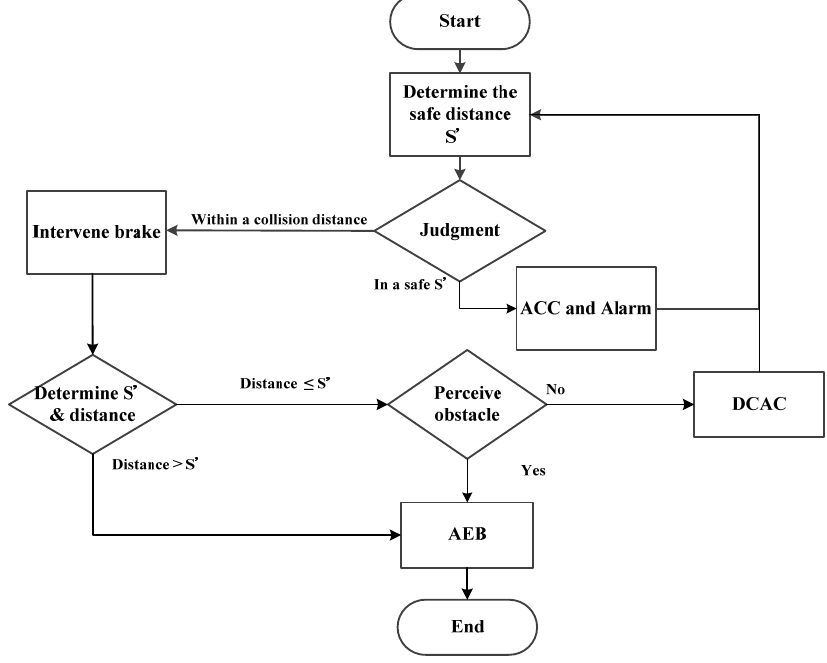
Figure 6. Flowchart of the proposed approach.